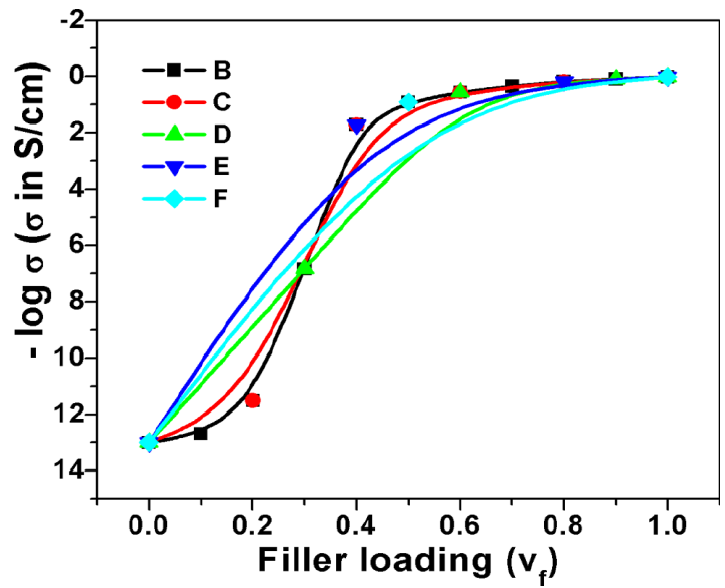
Figure 3. Variation of conductivity against filler loading (volume fraction) for same polymer composite at different interval of volume fraction, point of interval is decreasing from B to F.